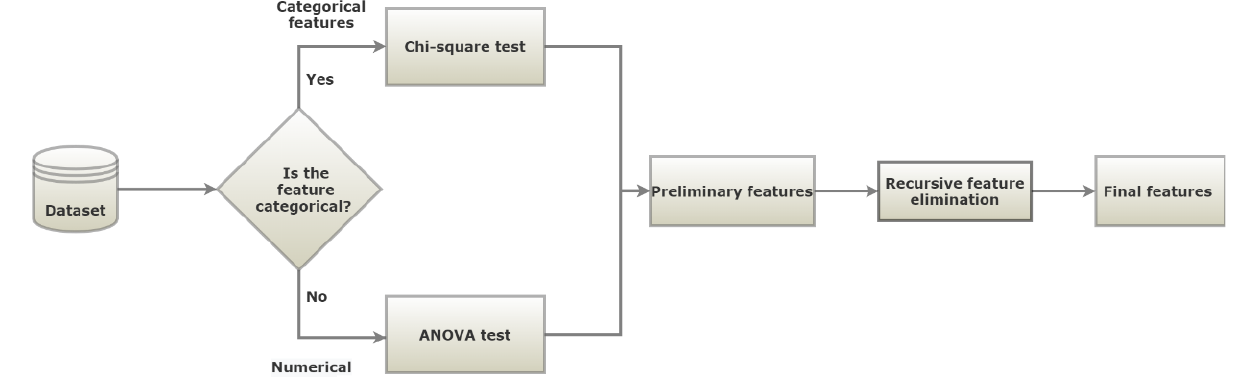
Figure 1. Feature selection procedure.